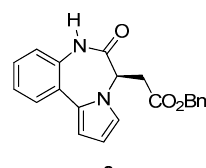
Figure 3. A biologically active pyrrolo[1,2- d ][1,4]benzodiazepine.